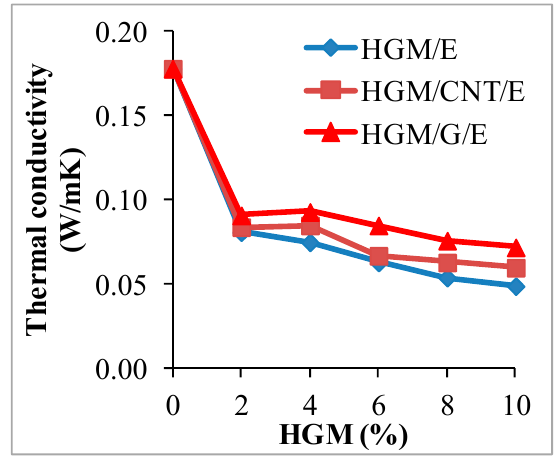
Figure 8. Thermal conductivity of composites.